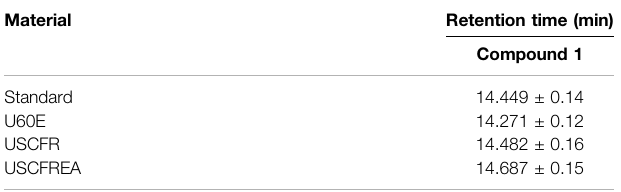
TABLE 1 | Retention time of compound 1 from Ulmus davidiana branch (with bark). Material